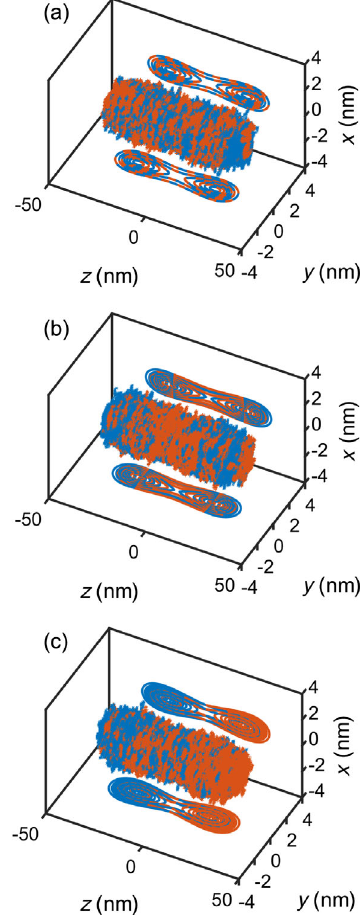
FIG. 8. Time-dependent positions of R ¼ 20 nm Au nano- spheres in a racemic mixture of 100 left-handed (in blue) and right-handed (in red) enantiomers simulated for 50 000 time steps of 95.4 ps for a total of 4 . 77 μ s. These trajectories are randomly picked among the 10 4 trajectories used to form the simulated PDF displayed in Figs. 6(b) and 7(b). We vary the chiral nature of the optical environment going through (a) an achiral optical envi- ronment, (b) a reactive chiral optical environment, and (c) a dissipative chiral optical environment. We can see that in the achiral case, the distribution is totally independent from the enantiomeric form of the nanoparticle, as expected. In the reactive case, in contrast, the chiral nanoparticles are either more con- centrated toward the center of the optical trap for the family of right-handed enantiomers (Re ½ χ (cid:3) > 0 ) or moved away to external regions for the left-handed enantiomers (Re ½ χ (cid:3) < 0 ). In the dissipative case, the chiral coupling is capable of inducing a deracemization process by progressively localizing enantiomers to different wells in strict relation with their enantiomeric Im ½ χ (cid:3) ≶ 0 forms. For each of the different types of couplings, the contour plots shown on the axis planes correspond to the ð q; z Þ ; p reac ð q; z Þ ; p diss ð q; z Þ PDFs given by predictions of the p χ χ opt our one-dimensional model. As well seen, our model successfully reproduces both the axial and radial